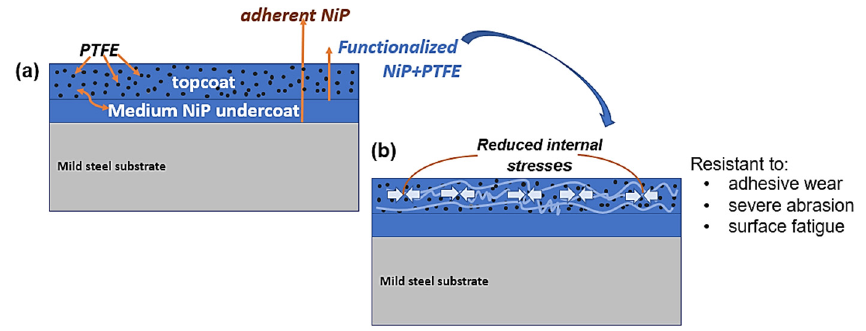
Figure 10. Schematics of ( a ) the structure of the proposed duplex coating and ( b ) the effect of the plating process and optimized PTFE content on improved properties of the coatings for effective wear control.